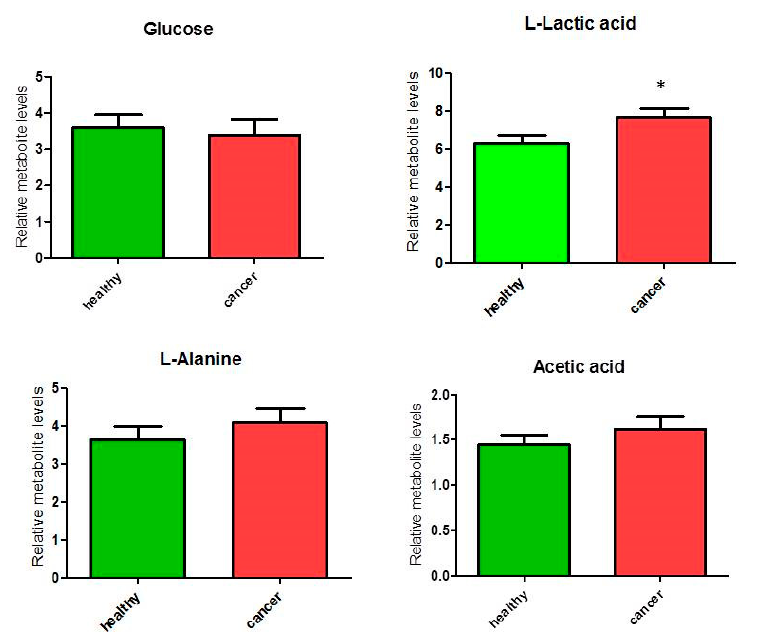
Figure 3. Percentage of metabolites (nmoles of metabolite relative to total nmoles of metabolites per g of tissue) involved in the glucose / pyruvate pathways in thyroid cancer tissue ( n = 11) and healthy thyroid tissues ( n = 10). Values are mean ± SD; (*) indicates ANOVA F 1,19 = 5.39; p = 0.032 and FDR q =